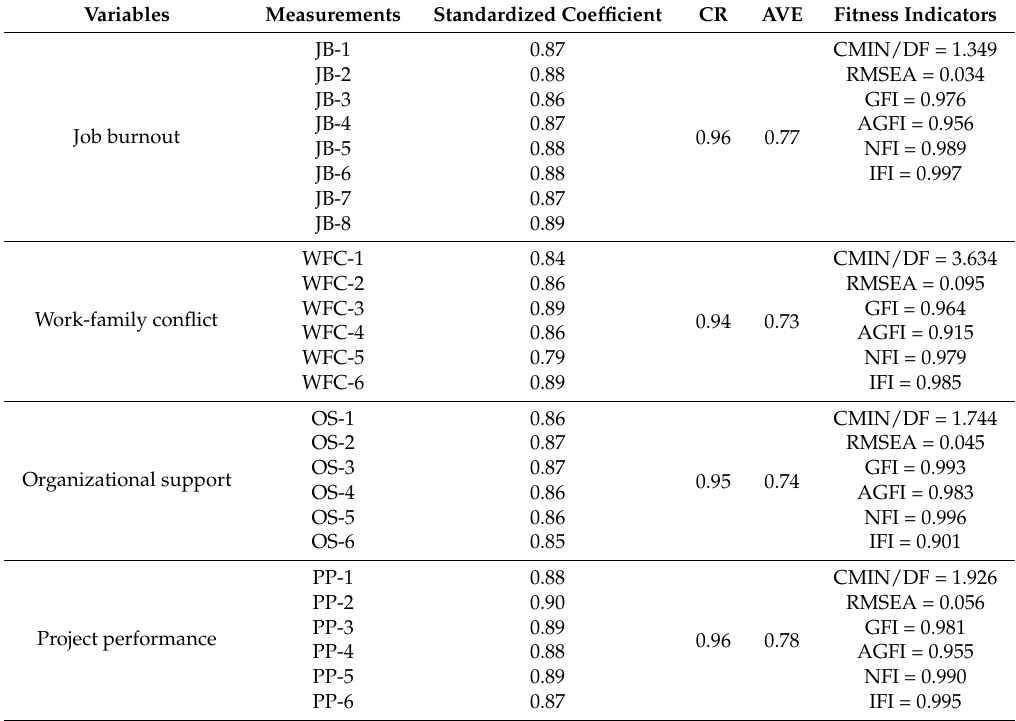
Table 4. Results of confirmatory factor